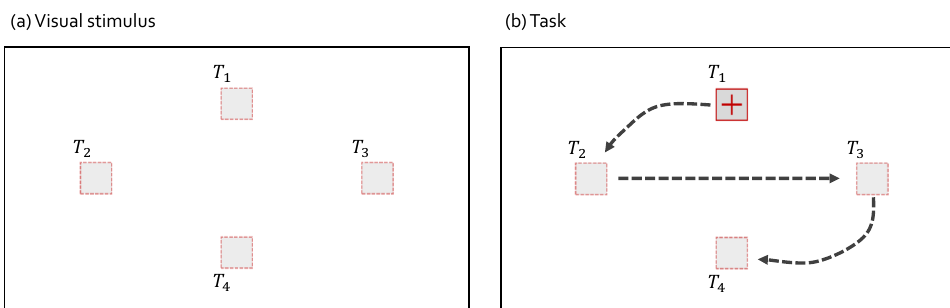
Figure 2. Visual stimulus and the task to collect gaze data for comparisons. We have used Tobii Pro